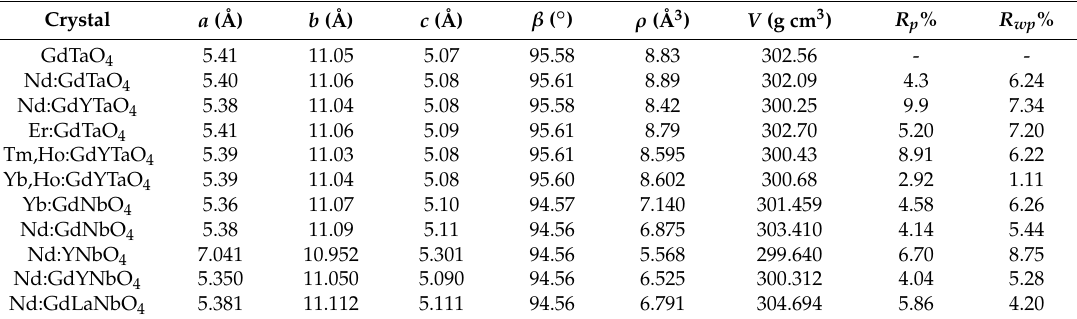
Table 1. Lattice parameters of as-grown crystals.